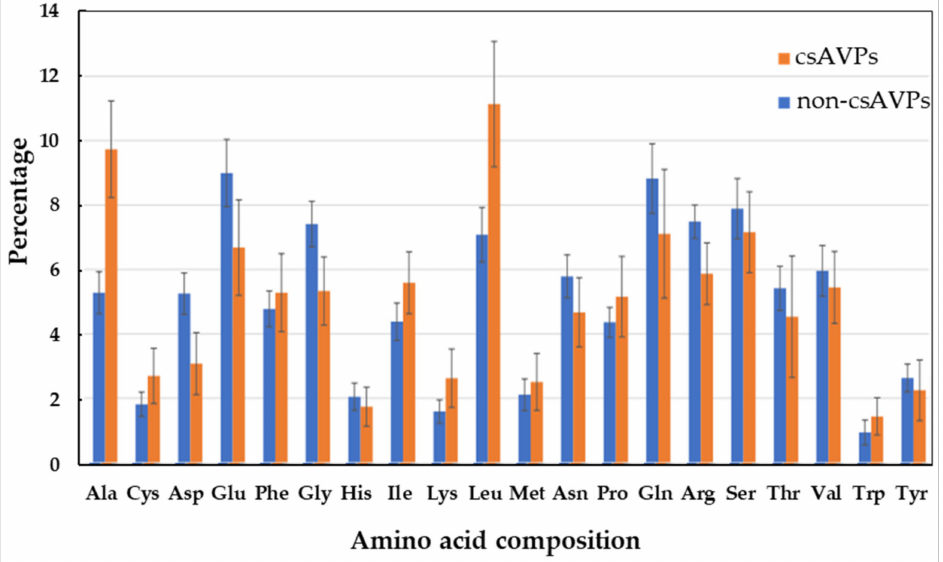
Figure 3. The comparative analysis of amino acid composition represents the preferences between the predicted csAVPs and non-csAVPs from hemp seed putative